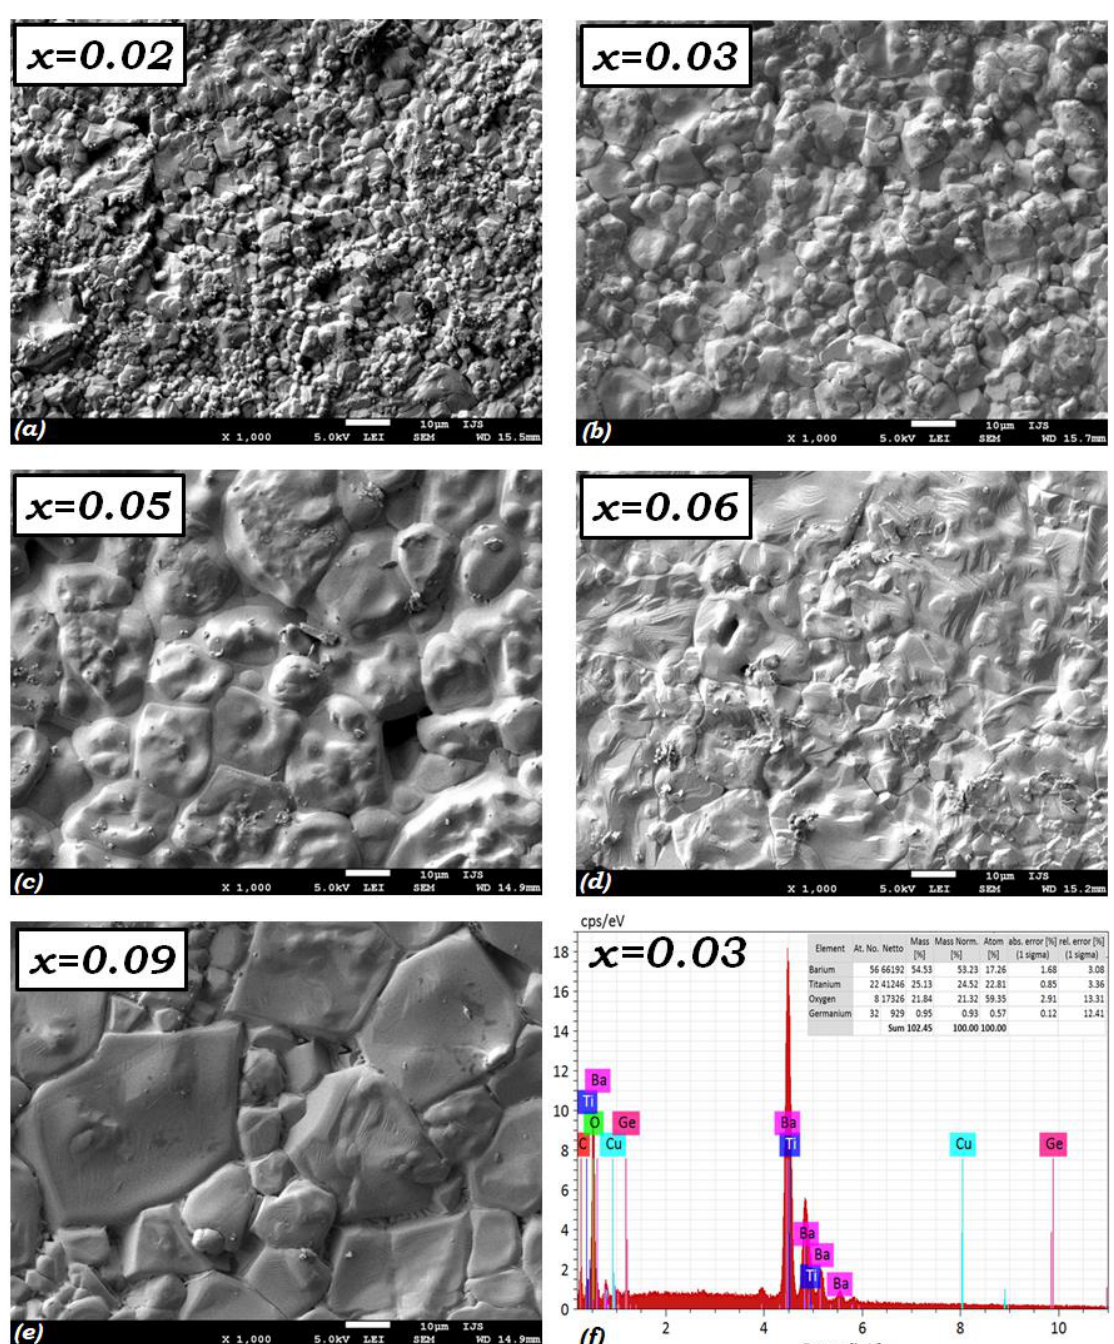
Figure 4. ( a – e ) SEM micrographs of BTGx (x = 0.02, 0.03, 0.05, 0.06, 0.09) ceramics and ( f ) EDX analysis of the composition BTG3 showing mass percentage of containing elements in agreement with the theoretical values.